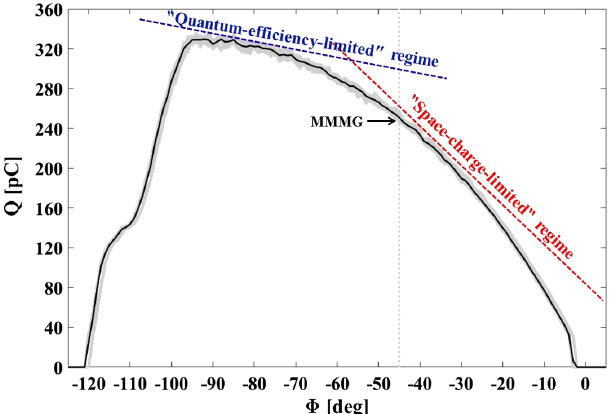
FIG. 7. A measured bunch charge scan over rf gun phases. Shading curves represent 10 individual measurements. The black curve shows the averaged data. For these measurements the amplitude set-point of the rf gun was chosen such that a beam energy of about 6 . 4 MeV = c was obtained at the exit of the gun section when the gun was operated at its MMMG phase. The applied pulse energy of the cathode drive laser was about 32